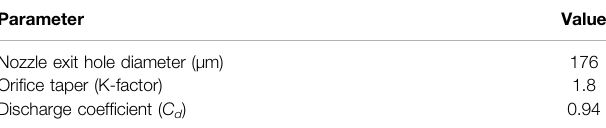
TABLE 2 | Single-hole injector speci fi